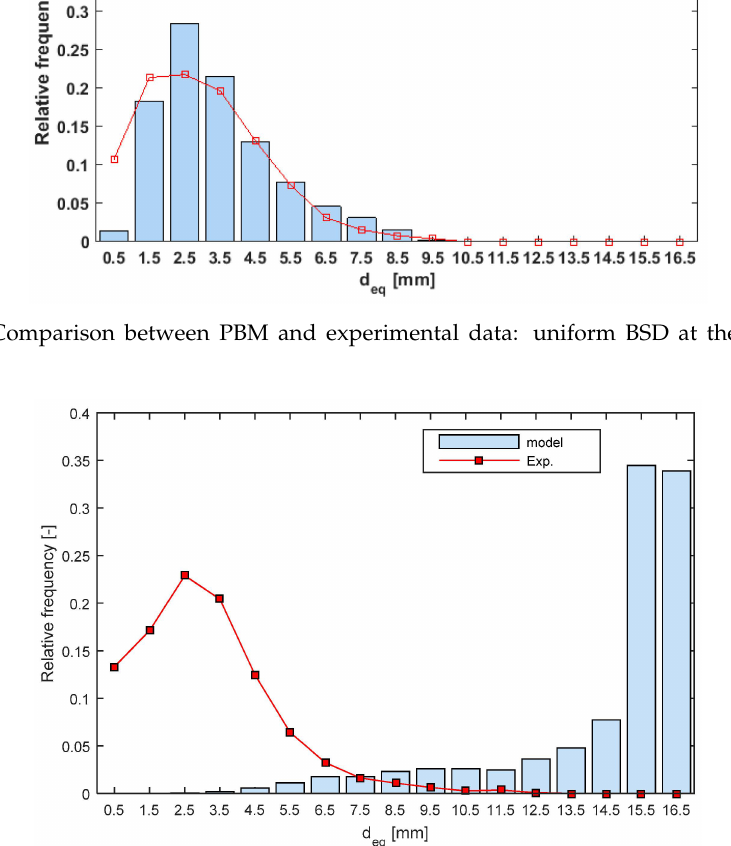
Figure 12. Comparison between PBM and experimental data: Martinez constant and real BSD at the inlet: U G = 0.0033 m/s.